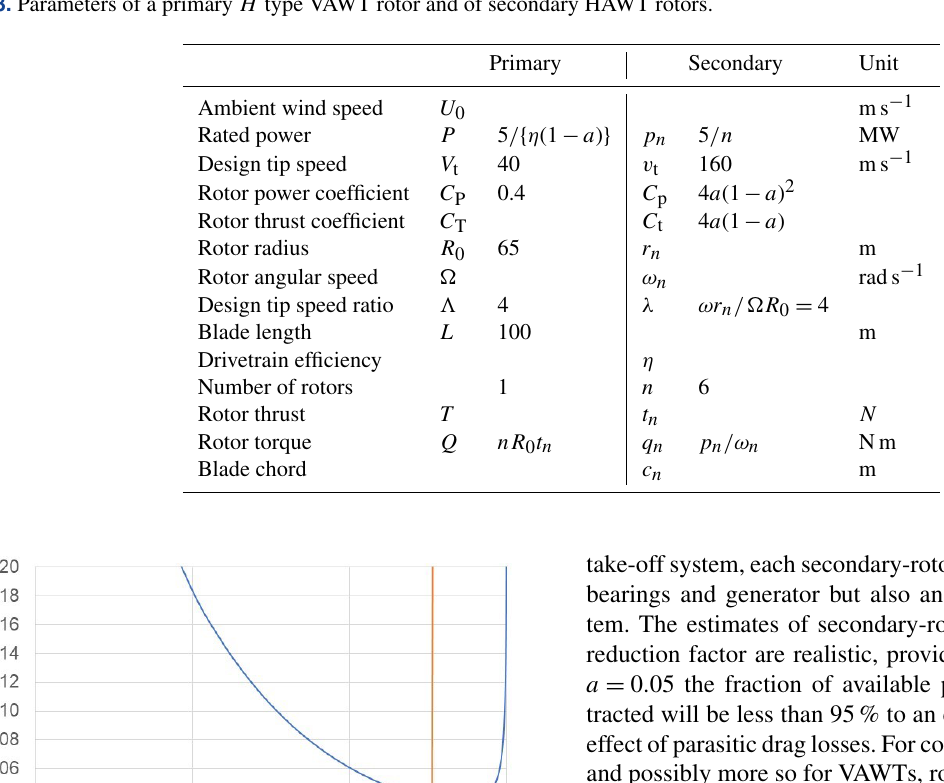
Table 3. Parameters of a primary H type VAWT rotor and of secondary HAWT rotors.